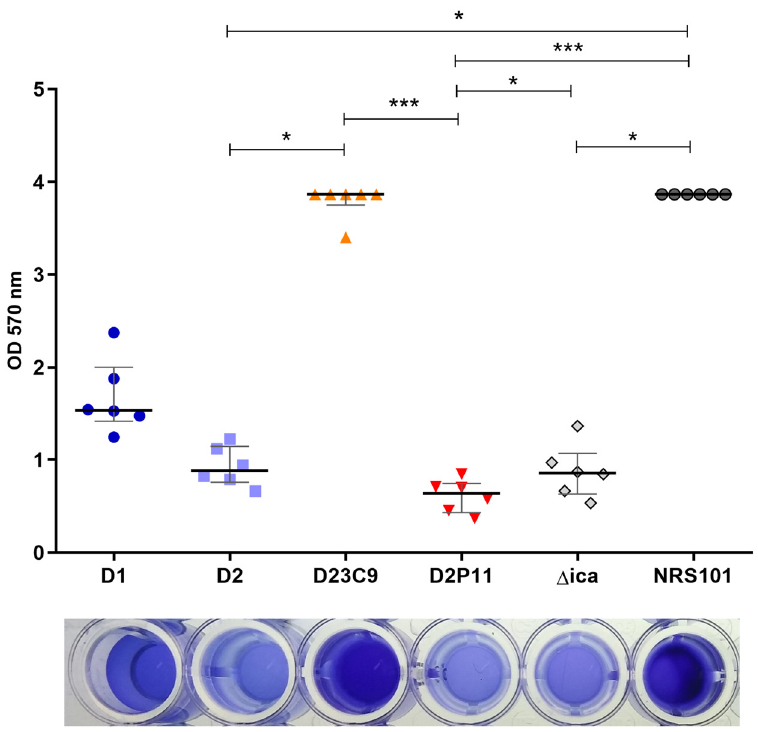
Figure 4. Biofilm production. Results are represented as final OD for each strain with median value (line) and interquartile range (whiskers) and are compared with Kruskal–Wallis’s test ( p < 0.0001). The horizontal bars show significant differences between individual groups detected by Dunn’s multiple comparison test. * p < 0.05; *** p < 0.001. NRS101 ( S. epidermidis NRS101), strong biofilm producer; ∆ ica ( S. aureus Newman ∆ ica ), ica independent-biofilm producer strain. The bottom picture shows a representative microtiter plate of the biofilm assay for each strain.